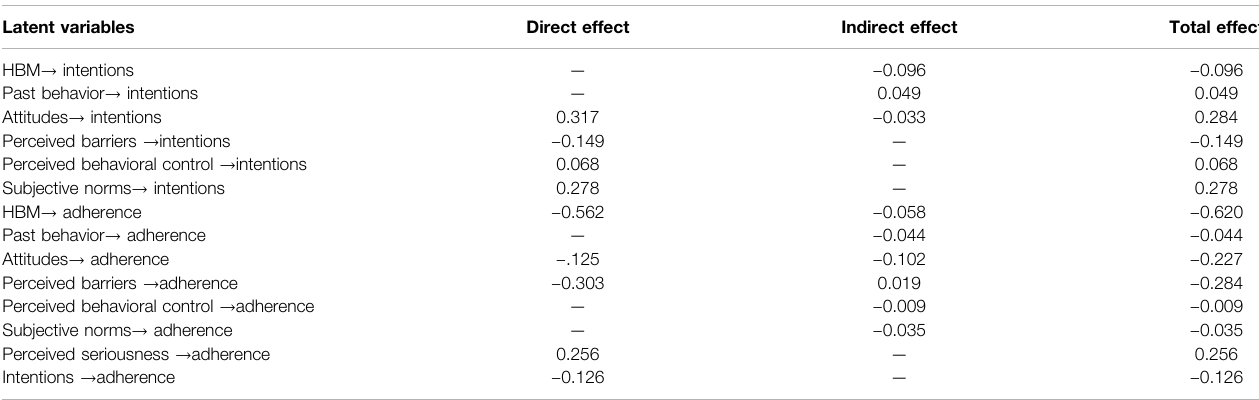
TABLE 6 | Effect of each latent variable of the structural equation model on medication intentions and